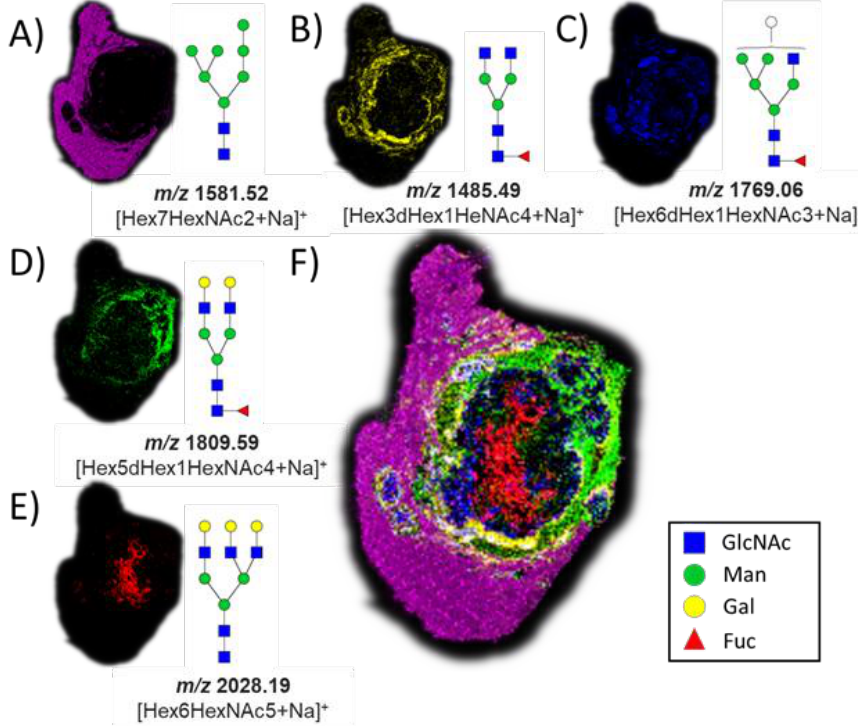
Figure 3. Ion maps of numerous N-glycans were detected by MALDI imaging as sodium-cationized species in different parts of the tissue after PNGase F treatment. ( A ) m / z 1581.52, Hex7HexNAc2; ( B ) m / z 1485.49, Hex3dHex1HeNAc4; ( C ) m / z 1769.06, Hex6dHex1HexNAc3; ( D ) m / z 1809.59, Hex5dHex1HexNAc4; ( E ) m / z 2028.19, Hex6HexNAc5; and ( F ) co-registered collection of glycans. The hematoxylin and eosin (H&E) stain of the same tissue section is shown in Figure 4 for